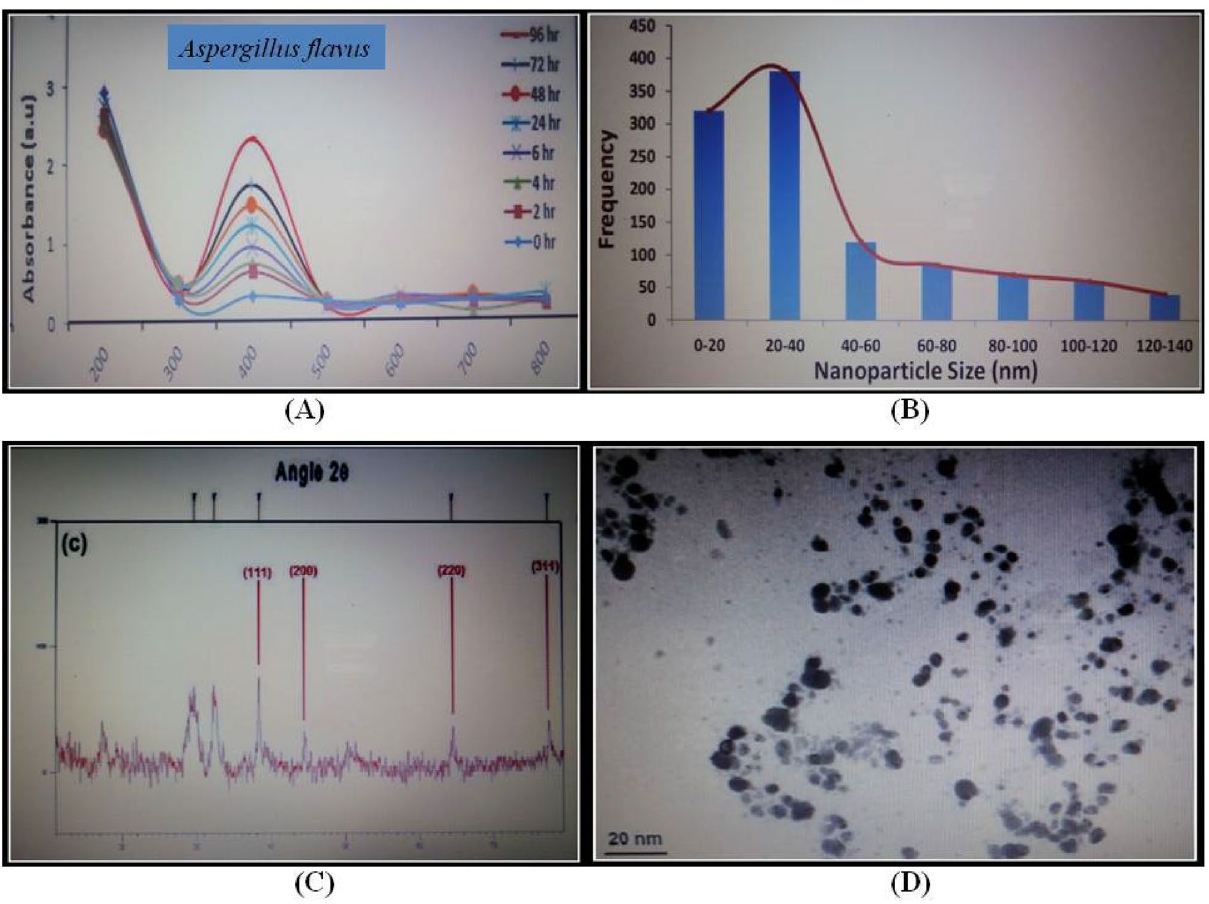
Figure 6. Characterization of AgNPs biosynthesized using Aspergillus flavus. ( A ) UV–Vis spectra recorded for the biosynthesis of AgNPs in response to 0.1 M silver nitrate inoculated media of A. flavus. ( B ) Size distribution profile of AgNPs synthesized prepared by cultural filtrates of A. flavus {A total number of 100 particles were analyzed}. ( C ) XRD patterns of AgNPs biosynthesized from cultural filtrates of A. flavus. ( D ) TEM micrographs of AgNPs produced by cultural filtrates of A.